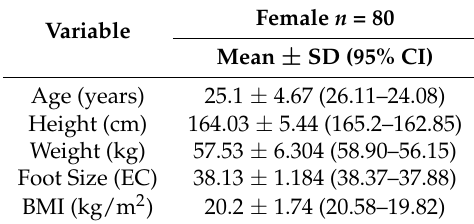
Figure 8. Participant flow chart. Table 1. Sociodemographic characteristics of the participants.